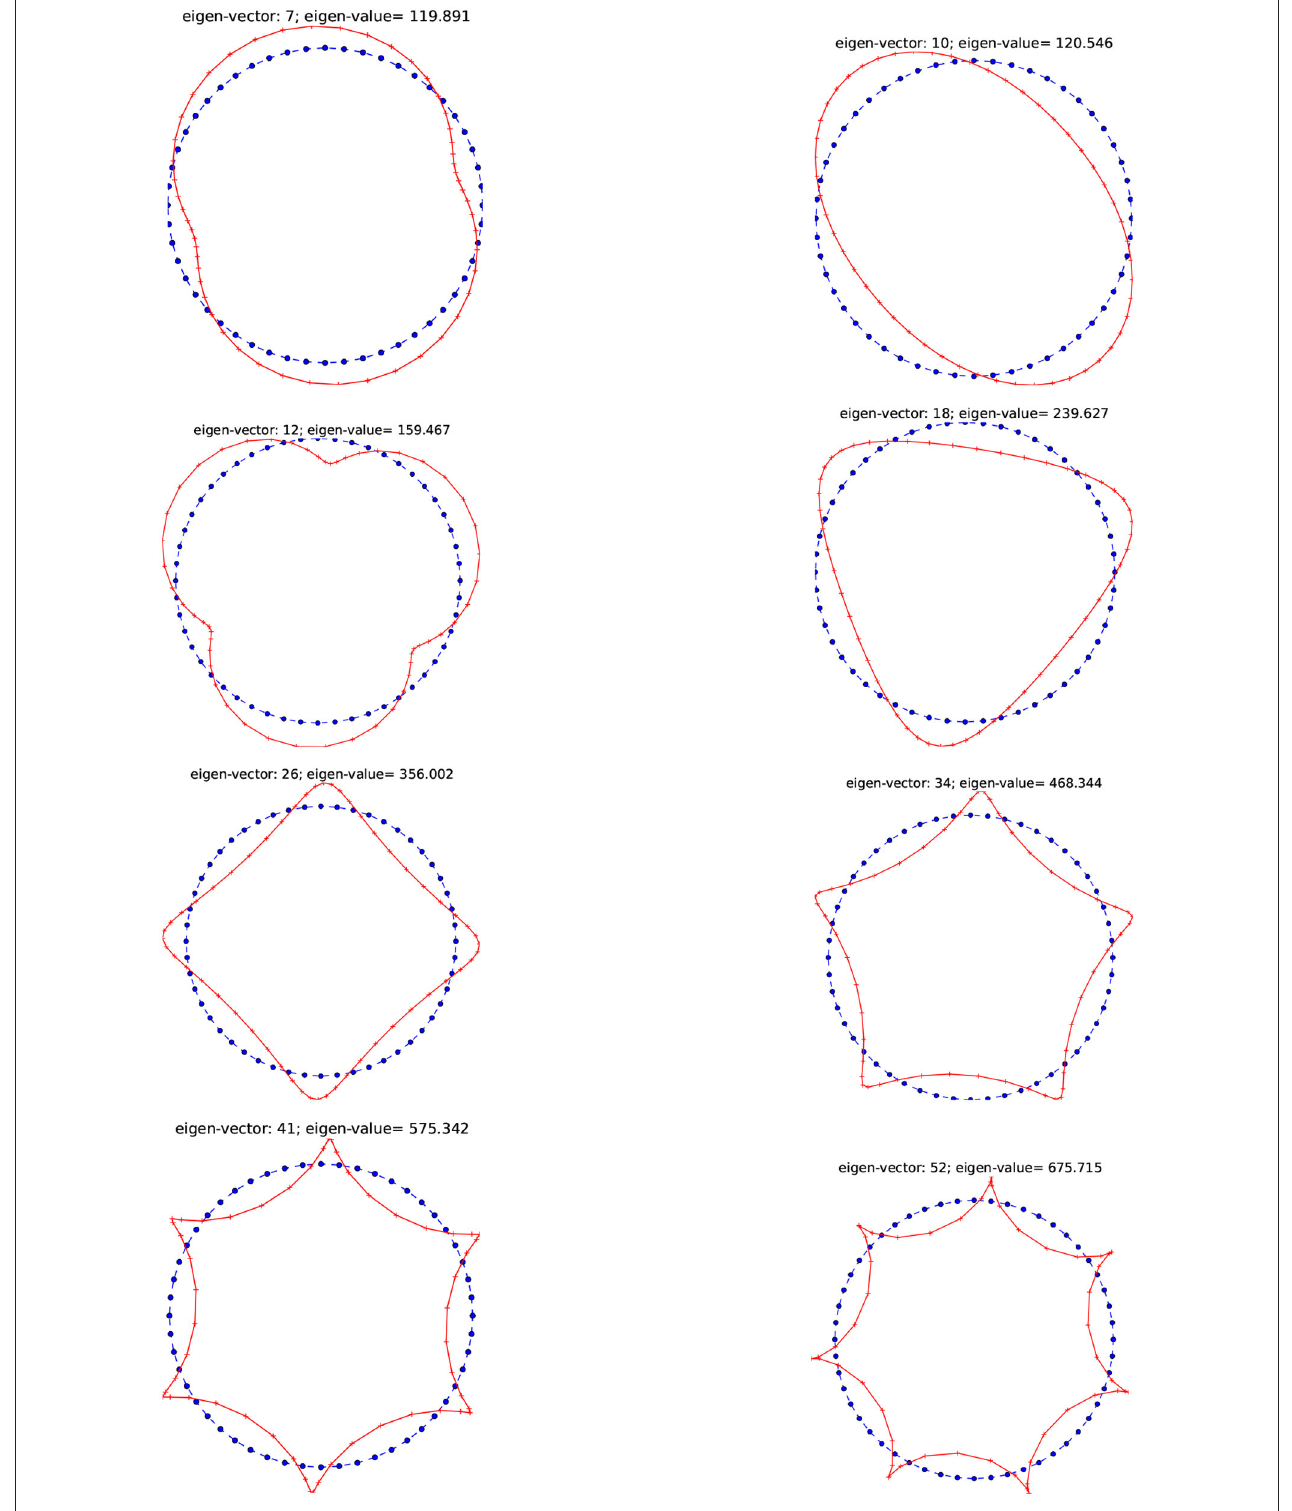
FIGURE 6 | Some of the eigenvalues and the corresponding eigenvectors of the symmetric BEM matrix A represented by the deformed shapes for the circular body.